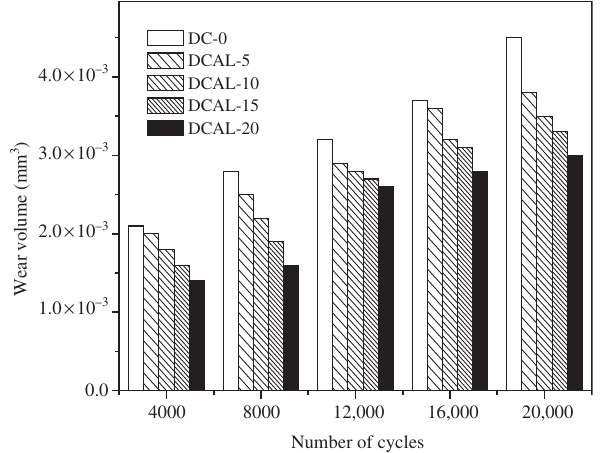
Figure 8: Effect of number of cycles on wear volume of the nanoalumina-filled dental composites.